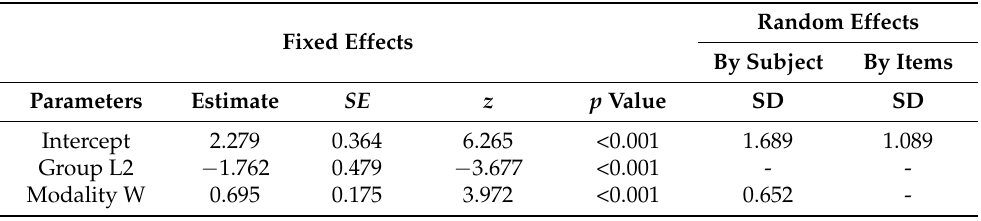
Table 5. Parameter estimates for L2 and HL learners’ accuracy with ungrammatical sentences.